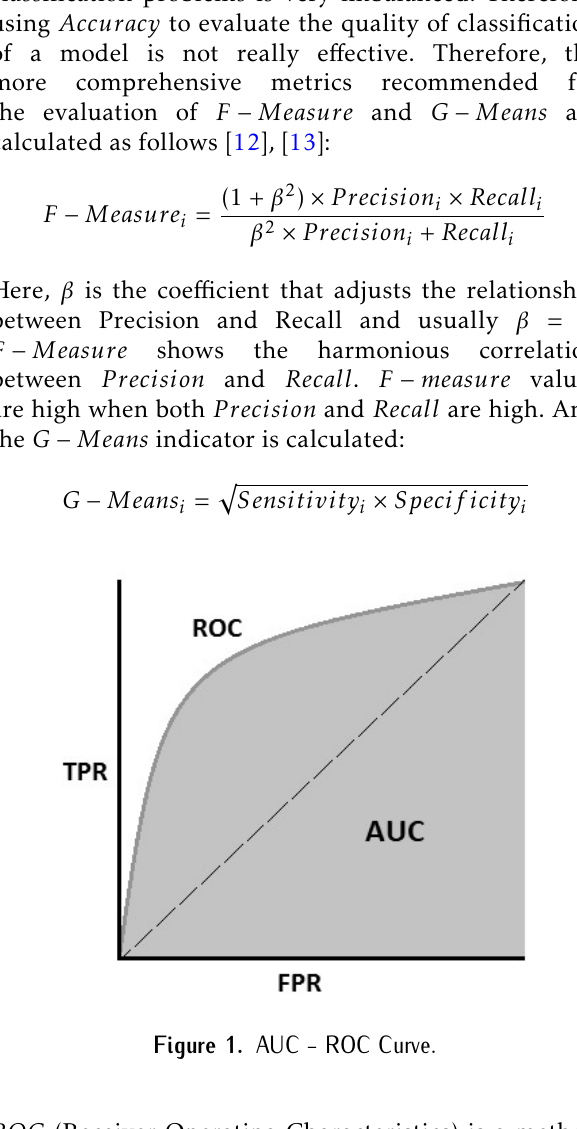
ROC (Receiver Operating Characteristics) is a method of calculating the performance of a classification model according to di ff erent classification thresholds. Assum- ing a binary classification problem (2 classes) using Logistic Regression, the selection of di ff erent classifica- tion thresholds [0..1] will a ff ect the classification ability of the model and the level of influence of thresholds needs to be calculated. ROC is a probability and Area Under The Curve ( AUC ) representing the degree of classification of the model. Meaning of the interpretable AUC : It is the probability that a randomly sampled positive sample will be ranked higher than a random- The higher the AUC , the more accurate the model is in classifying classes. The ROC curve represents the